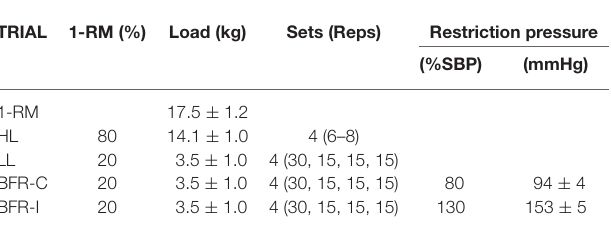
TABLE 1 | Maximum strength (1-RM) and exercise workload characteristics for each trial